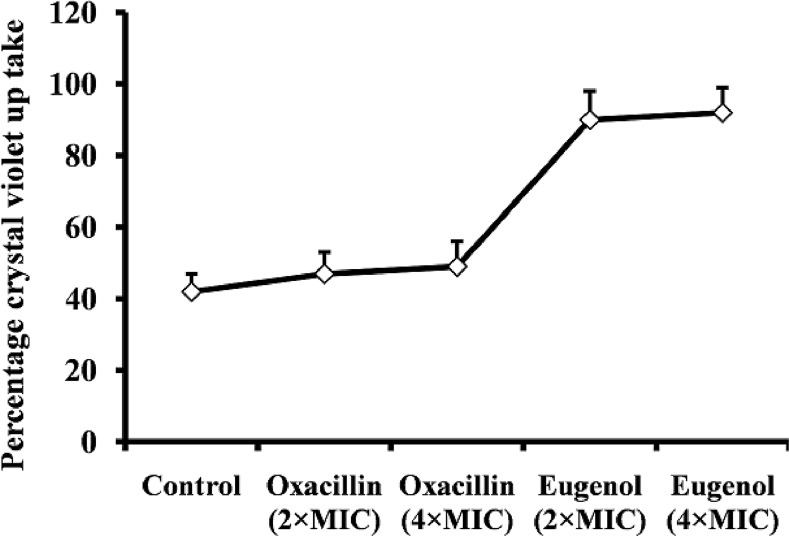
Crystal violet uptake of eugenol and oxacillin-treated S. aureus (ATCC 29213).The bacteria were treated with 2×and 4×MIC of eugenol or oxacillin and crystal violet absorption was assayed as show in the methods section. The mean ± SD for three replicates are presented.